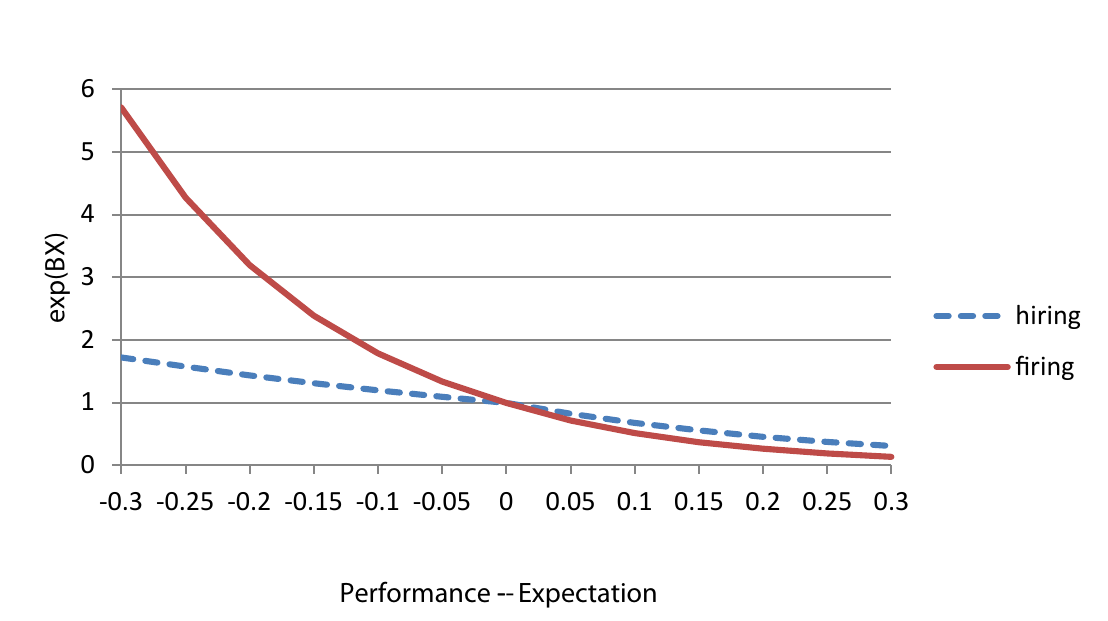
Figure 3. Estimated hazard multipliers for performance relative to